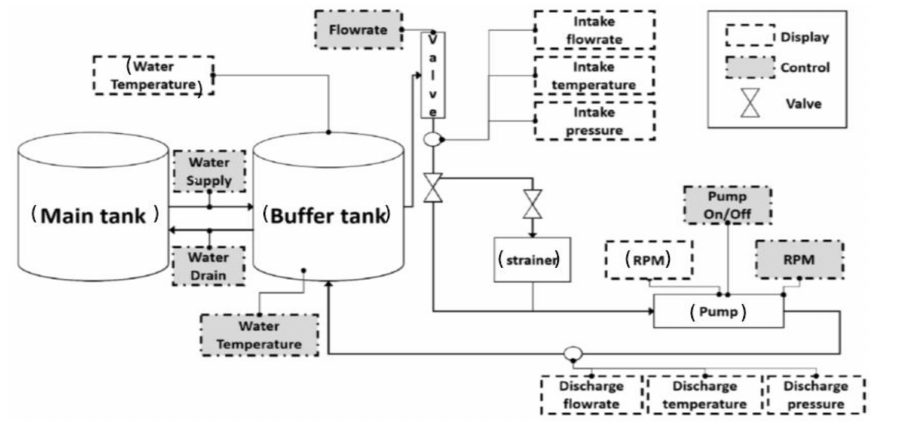
Figure 3. Block scheme of the experimental testbed. Table 1. Attributes of the testbed for data acquisition.